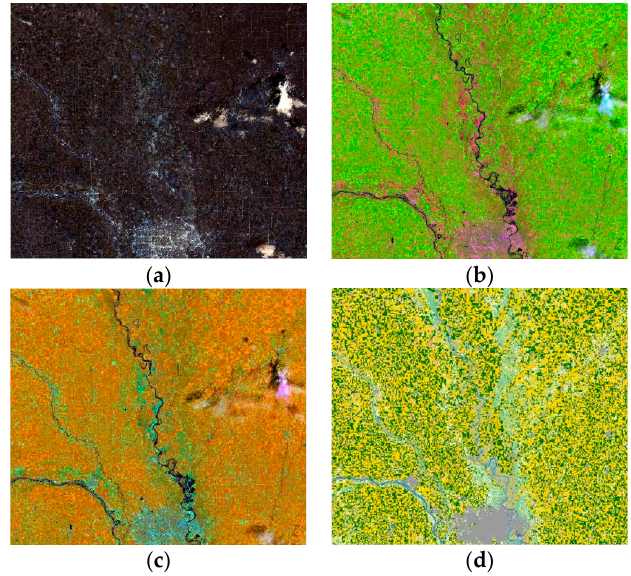
Figure 2. Part of the training data produced: ( a ) 432 band fusion image; ( b ) 652 band fusion map; ( c ) 564 band fusion map; ( d ) corresponding CDL data. ( a – c ) are obtained by Landsat 8 satellite on 7 August 2019.